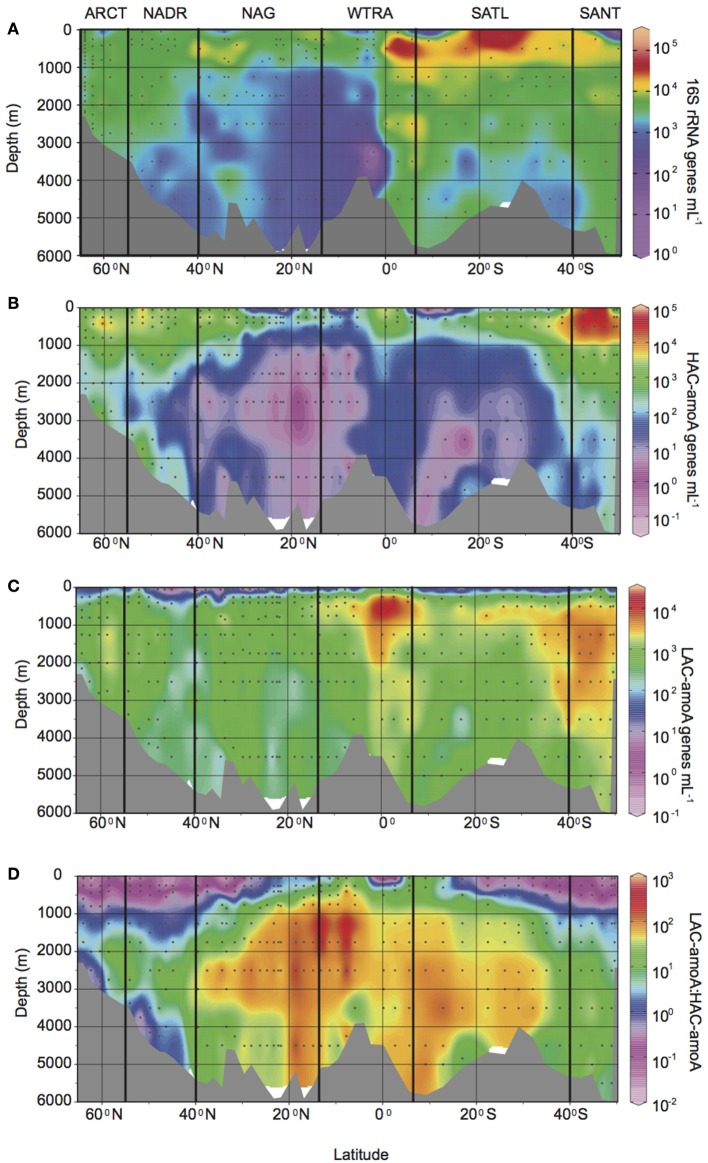
Gene abundance (genes mL−1) throughout the Atlantic Ocean determined by q-PCR: of (A) thaumarchaeal 16S rRNA gene, (B) HAC-amoA and (C) LAC-amoA gene, (D) ratio between archaeal LAC-amoA and HAC-amoA gene abundance. Bold vertical lines denote borders between oceanic provinces based on the description given in Longhurst (2007) as detailed in Figure 1.